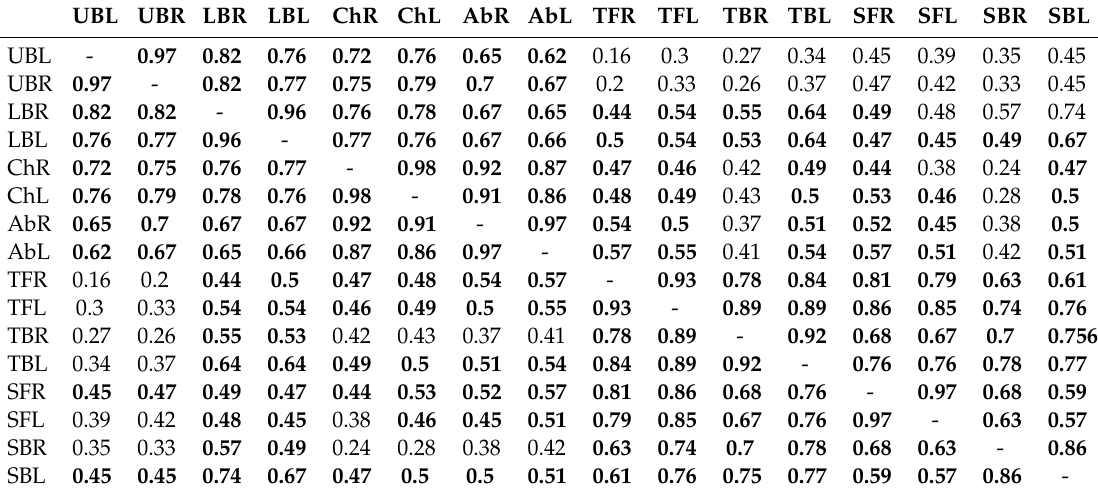
Table 3. Values of the correlation coe ffi cient between the mean values of the temperatures of selected body areas in children with scoliosis.